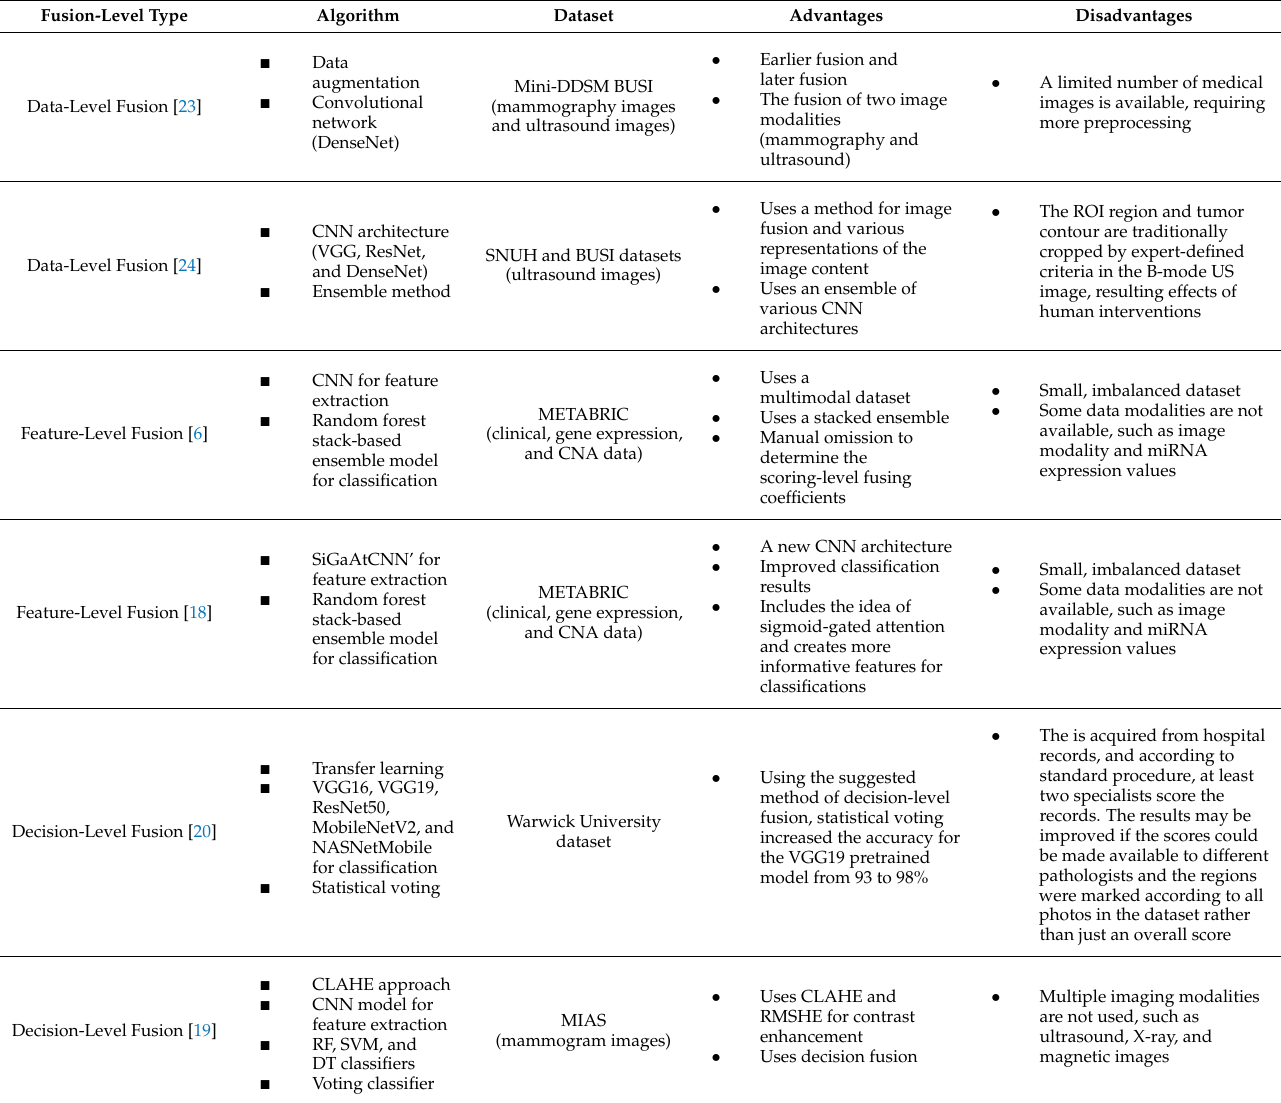
Table 1. Fusion-level models for breast cancer classification reported in the